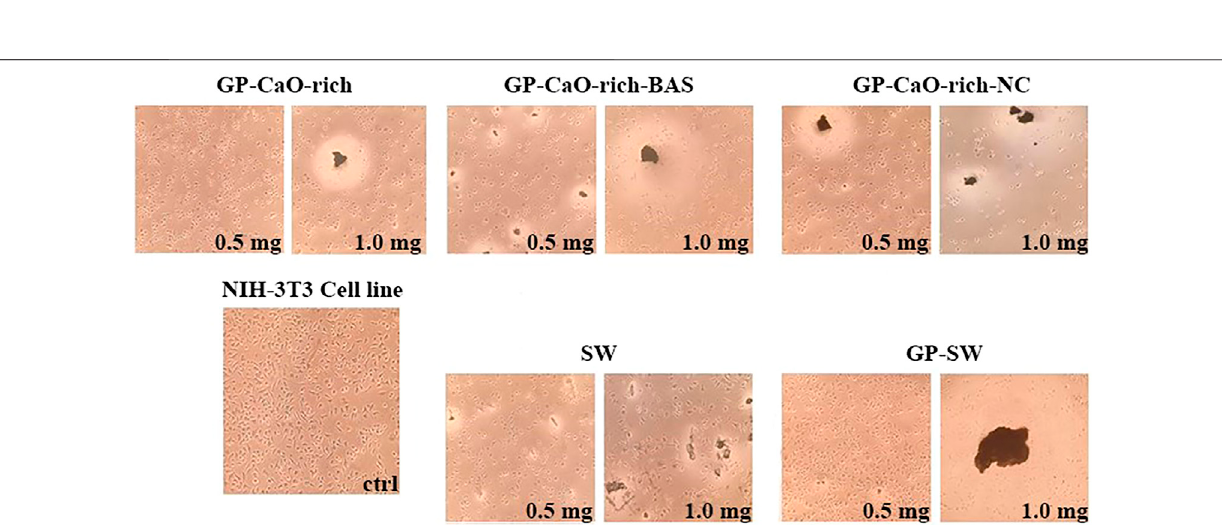
Frontiers in Materials |